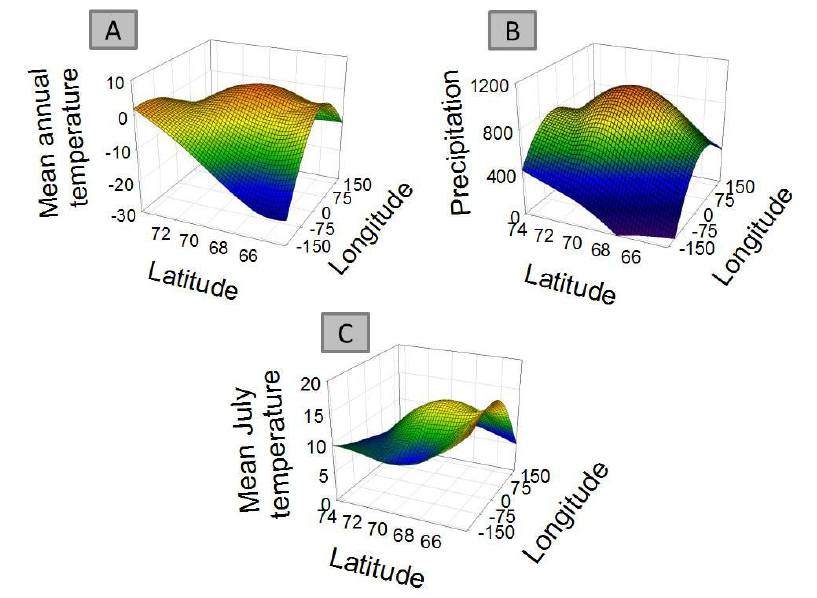
Figure 4. Main distribution of average temperature ( A ), precipitation ( B ), and mean temperature of the warmest month (July) ( C ) data in longitude and latitude axis system, as average temperature for the period 1996- 2005 (A) and average yearly precipitation (B) recorded at each longitude/ latitude